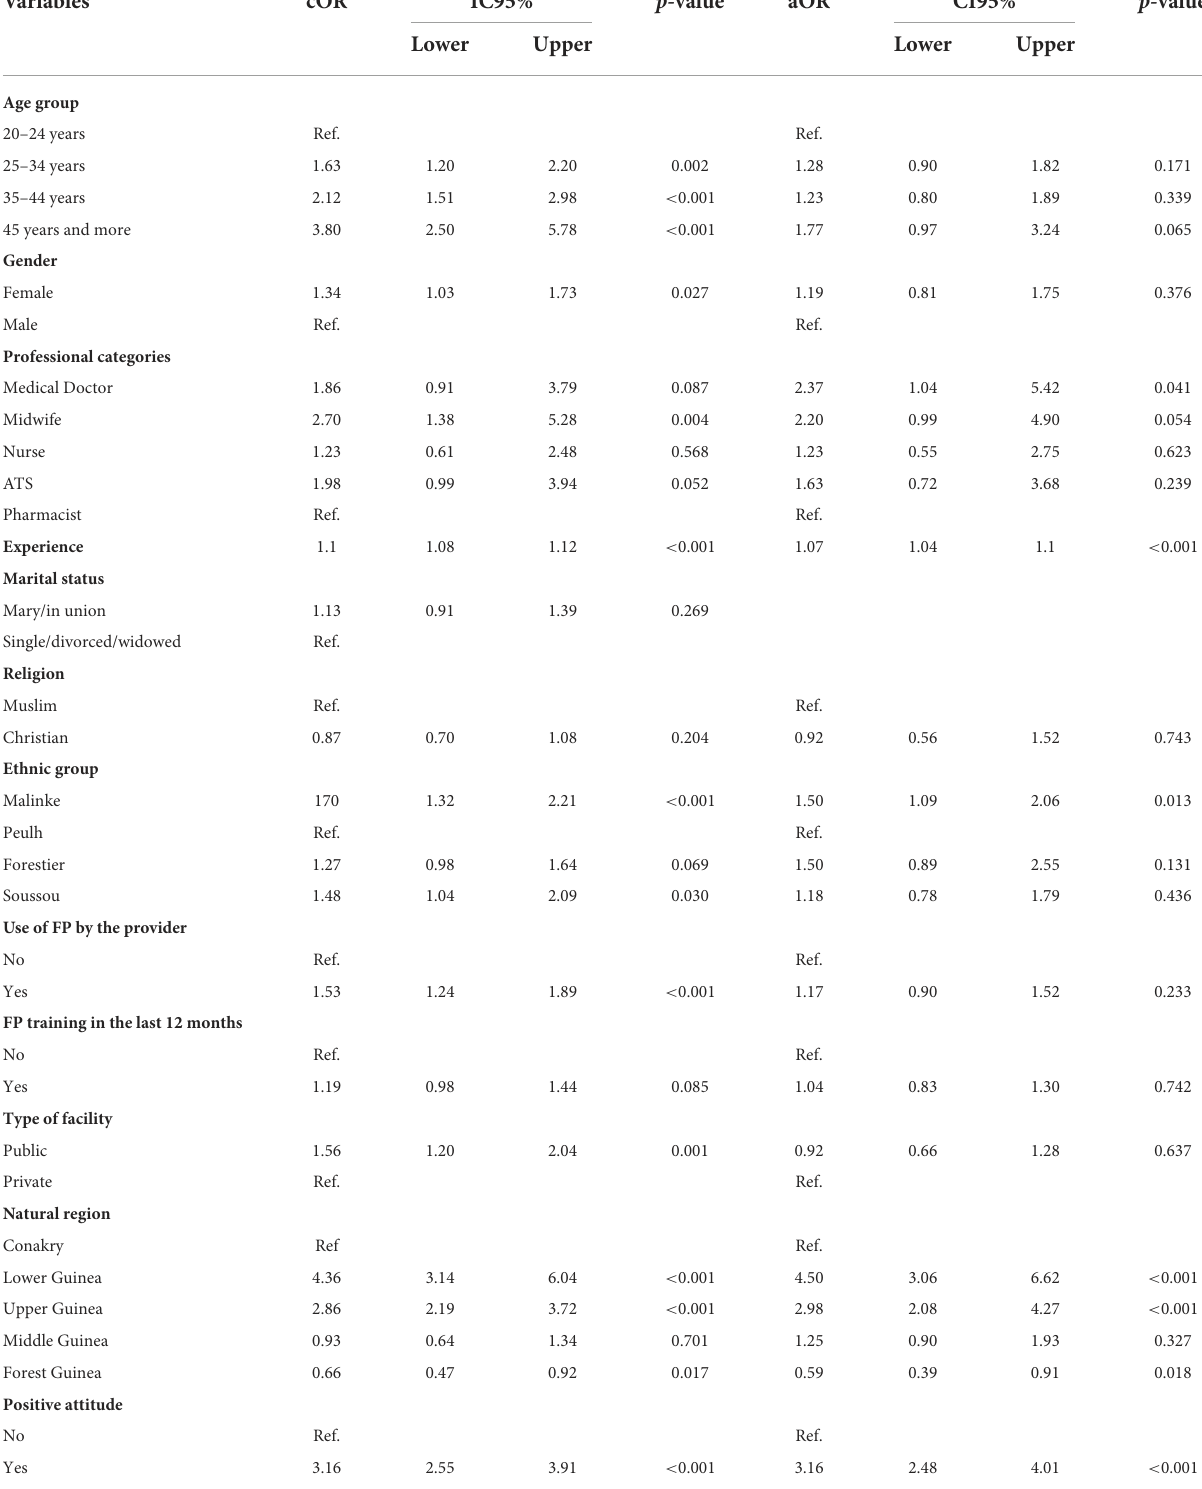
TABLE 6 Factors associated with providers’ good practices in prescribing contraceptive methods to adolescents and youth, Guinea, January-March 2021, ( N = 1,707). Variables cOR IC95% p -value aOR CI95% Lower Upper Lower